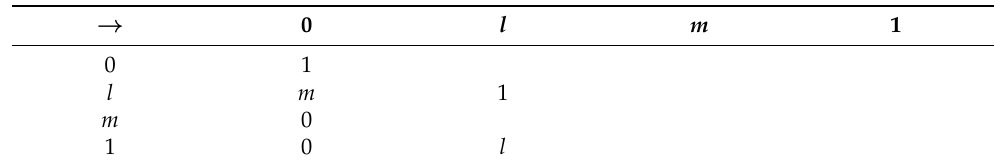
Table 8. The partial operation → .